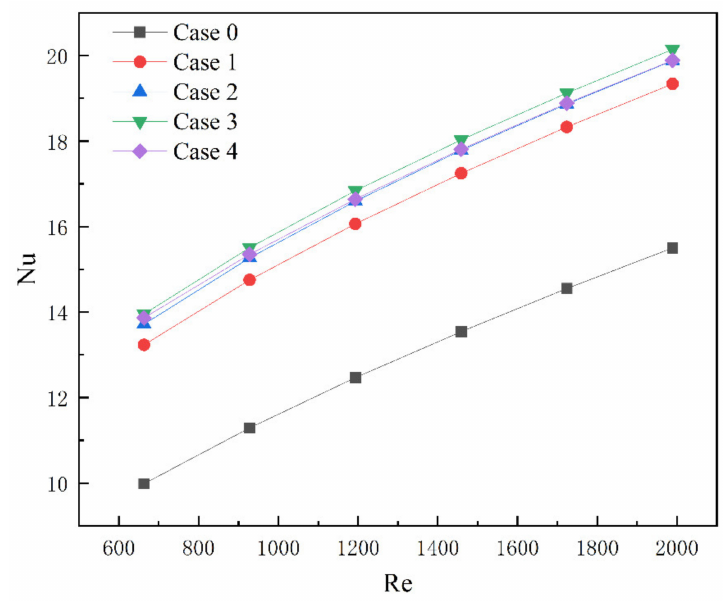
Figure 11. Nusselt number of Cases 0–4 at different Reynolds